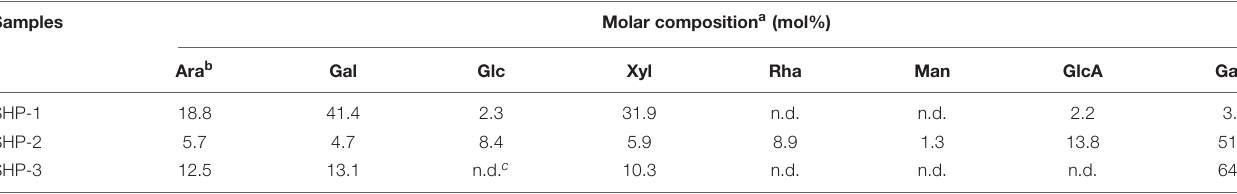
TABLE 1 | Monosaccharide compositions of purified polysaccharides of sesame hulls.